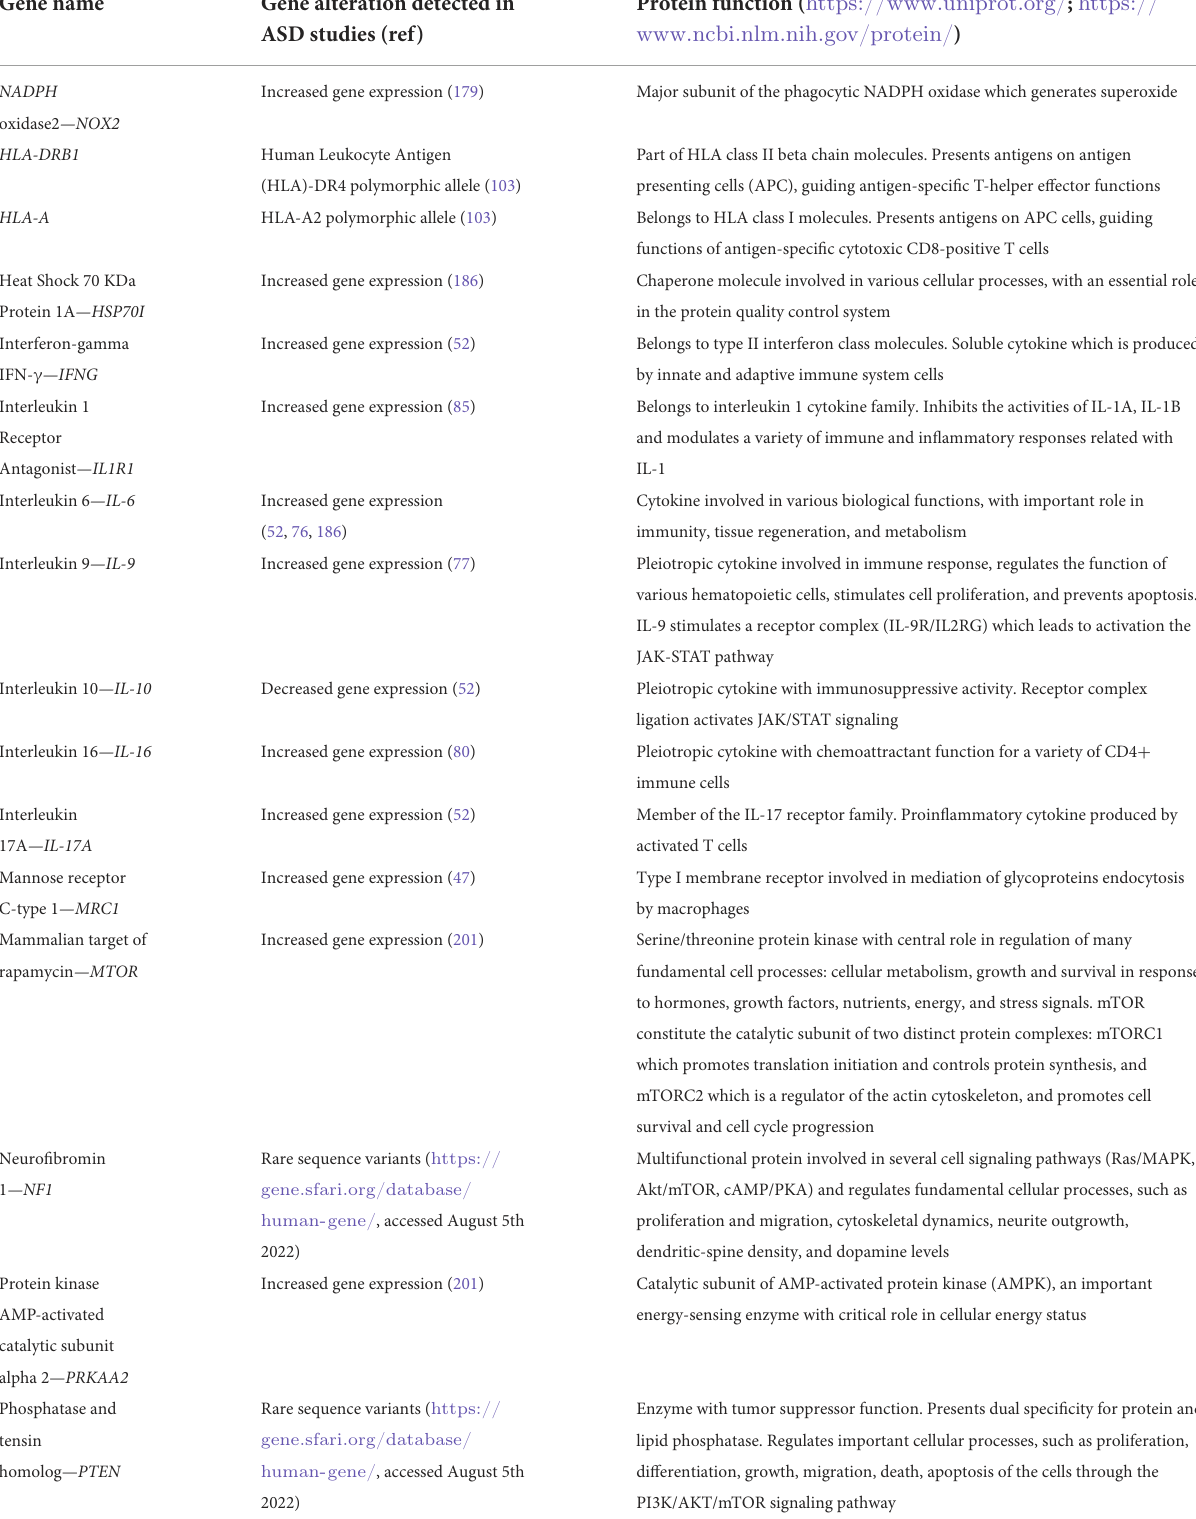
TABLE 2 Summary of immune-related genes with dysregulated expression in various ASD